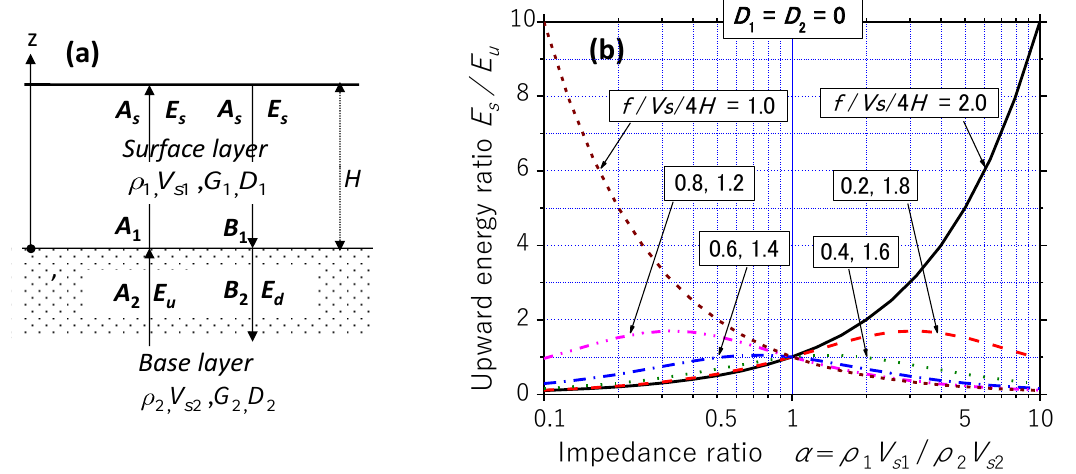
Figure 4. Two-layer system with harmonic wave propagation ( a ), and upward energy ratio between surface and base E s / E u versus impedance ratio α for damping ratio D 1 = D 2 = 0 ( b ). Figure 4b depicts the surface energy ratio E s / E u in Equation (19) for stepwise varying normalized frequencies, f /( V s /4 H ), versus the impedance ratio α in the log-scale for zero internal damping ( D 1 = D 2 = 0). The energy ratio varies symmetrically with respect to the center axis α = 1.0 where E s / E u = 1.0 quite reasonably. The maximum energy in the surface layer occurs in the first resonance, f /( V s /4 H ) = 1.0, for α < 1.0, whereas it occurs in the second resonance, f /( V s /4 H ) = 2.0, for α > 1.0, when E s is much larger than E u reflecting energy accumulation in the surface layer due to the resonance. By substituting k 1 H = ω H / V s 1 = π /2 into Equation (19), E s / E u = 1/ α is obtained as the maximum energy ratio in the first resonance, indicating that the softer the surface soil is, the larger the energy becomes in resonance stored in the surface layer. For off-resonance frequencies such as f /( V s /4 H ) ≤ 0.6 or ≥ 1.4, E s tends to be much lower than E u with decreasing α for α < 1.0. In Figure 5a, the upward energy ratio E s / E u calculated by Equation (19) for the two- layer model where the internal damping ratio in the surface layer D 1 = 5% is depicted versus α . The energy E s tends to decrease evidently compared to the case of D 1 = 0%, although the energy accumulation effect near resonance in the surface layer can still be recognized. In Figure 5b, the dissipated energy ratio calculated in Equation (21) for D 1 = 5% is shown versus α . A considerable energy E w out of E u tends to be dissipated rather than stored in and near resonance due to the multi-reflection of the wave trapped in the surface layer.